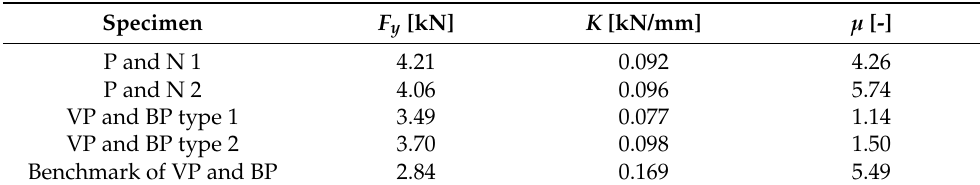
Table 5. The seismic performance parameters from the bilinear diagrams of the full-scale in-plane cyclic tests.